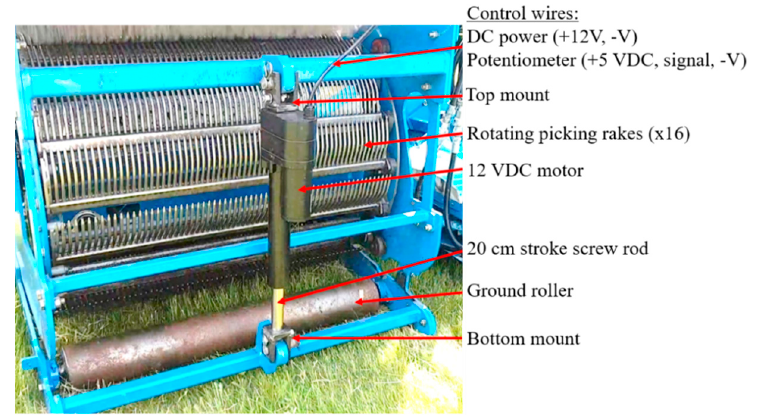
Figure 6. DBE harvester head showing components of the electric actuator setup.